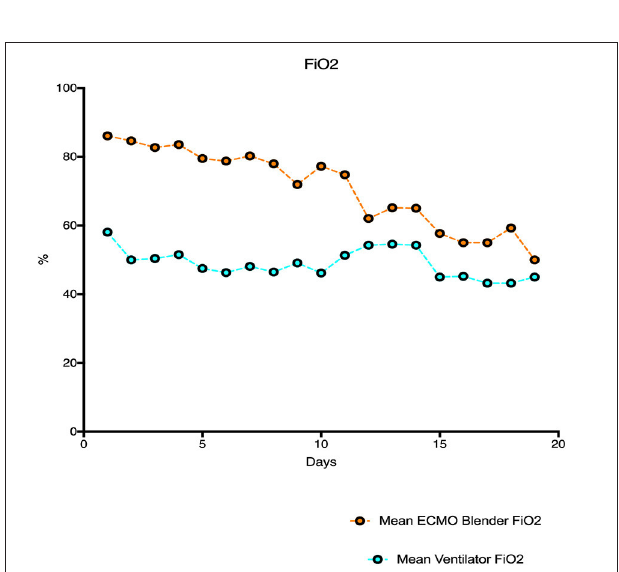
FIGURE 1 | Mean ECMO blender FiO 2 and mean ventilator FiO 2 for the duration of ECMO support.